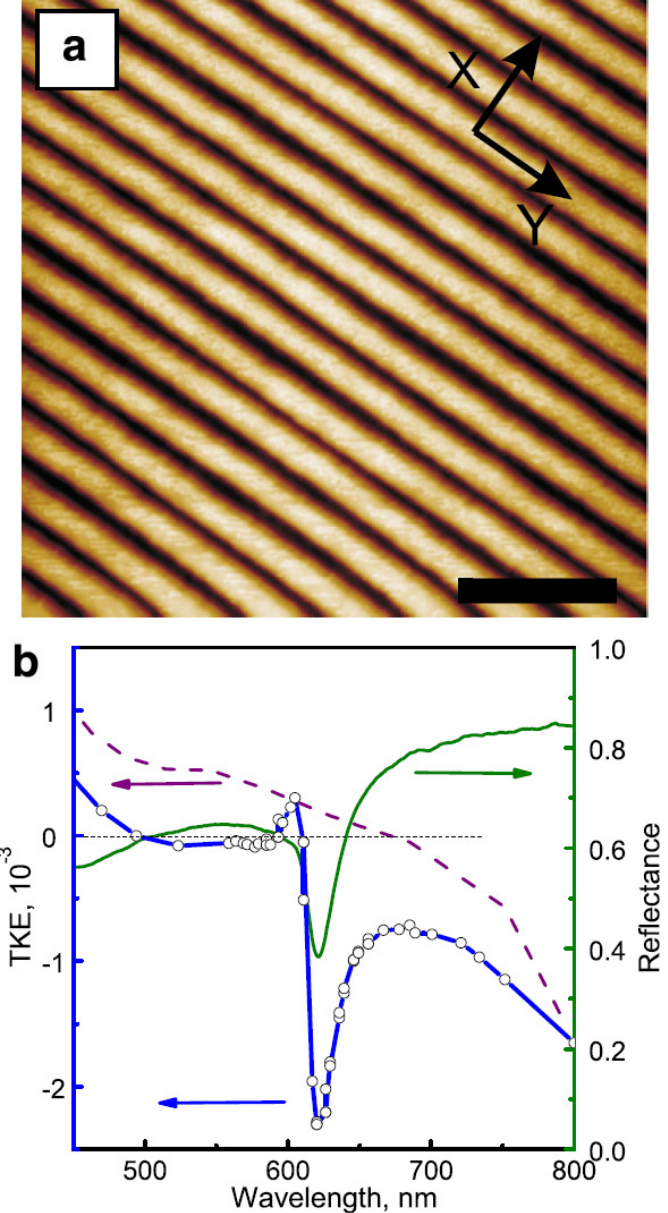
Figure 2. ( a ) The AFM image of the all-nickel magneto-plasmonic grating. Black bar is equal to 1 µ m; ( b ) TMOKE spectra of the one-dimensional magneto-plasmonic grating (circles) and the reference plain nickel film (dashed curve). The solid line shows the reflection spectrum of the grating. Reproduced from [50] with permission by AIP Publishing LLC, Copyright